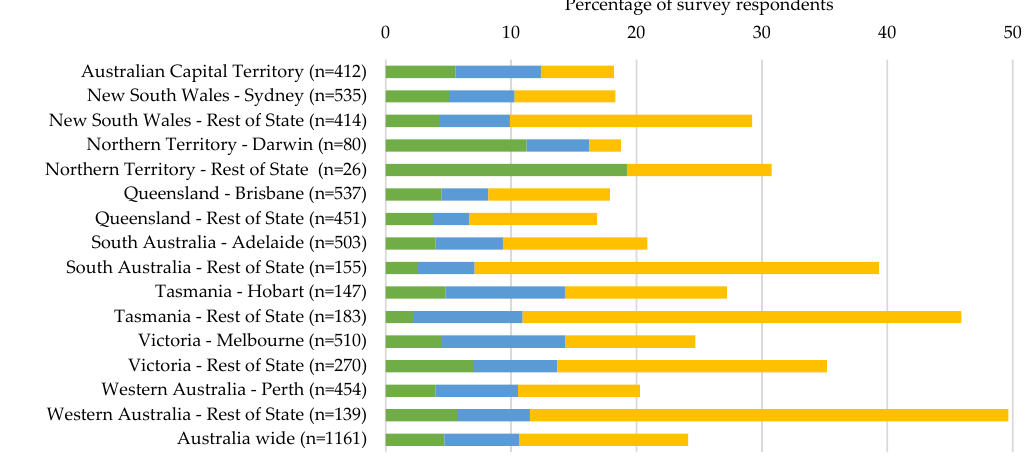
Figure 1. Percentage of survey respondents who reported using firewood in each GCCSA location across Australia. In terms of climate zone, the use of firewood for indoor space heating was signifi- cantly lower in climate zones with warmer winters (e.g., climate zones 1 and 2, which are characterised by warm winters) and higher in climate zones with cooler winter (e.g., cli- mate zone 4, which is characterised by cool winter, and climate zone 6 and 7, which are characterised as mild and cool temperate, respectively).